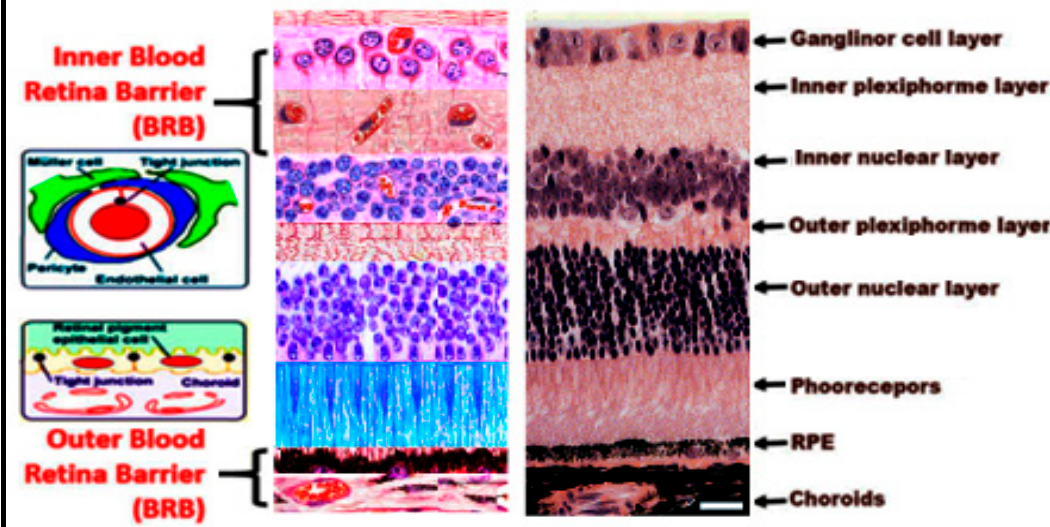
Figure 3. Schematic figure showing the blood retinal barrier arrangement and the components of both the inner and outer blood retinal barrier. The blood retinal barrier has two components, the inner and outer components (inner blood retinal barrier (BRB) and outer BRB). The inner BRB is formed by tight junctions between vascular endothelial, which is surrounded by glial cells, muller cells, and pericytes cells. The outer blood retinal barrier is formed by tight junctions between retinal pigment epithelial cells (RPE), which rests on bruch’s membrane separating RPE from the fenestrated choriocapillaries. Scale bare is 20 µm.